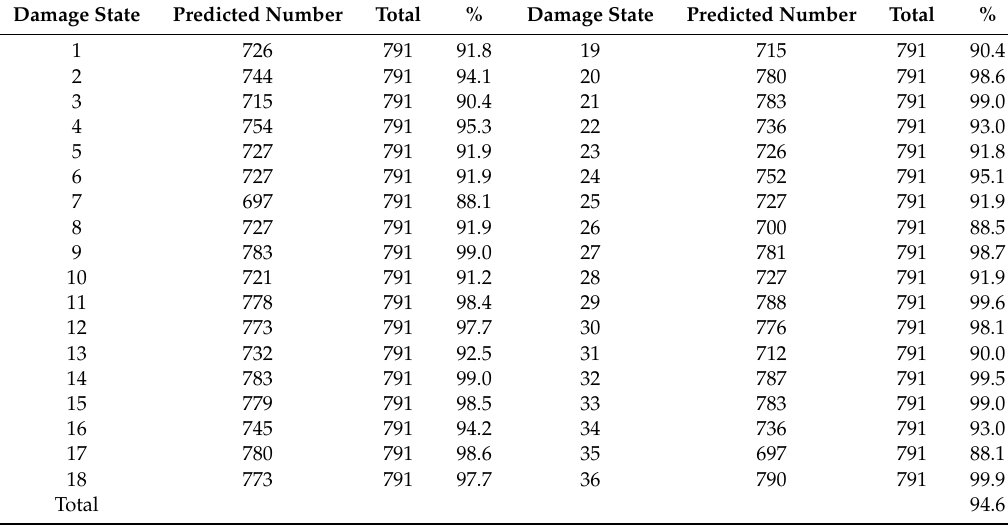
Figure 12. Training process of dataset B. Table 6. Detection results of dataset B.